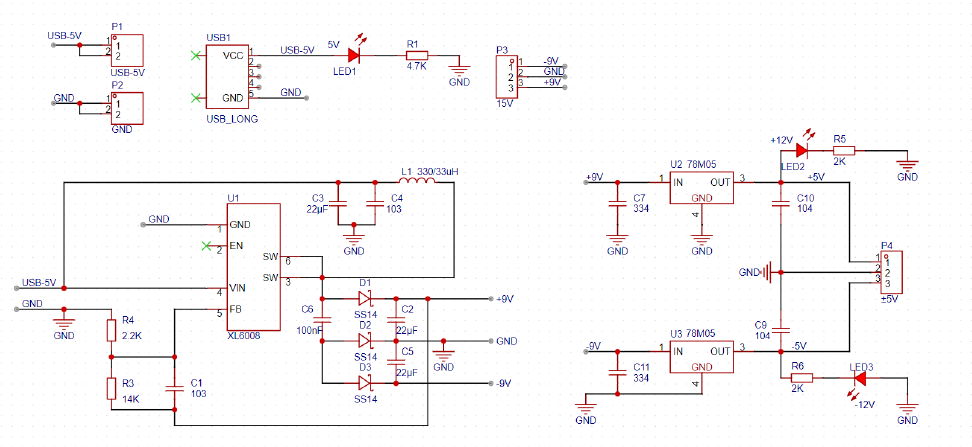
Figure 10. Circuit diagram of 2.8 V–9 V to ±5 V.